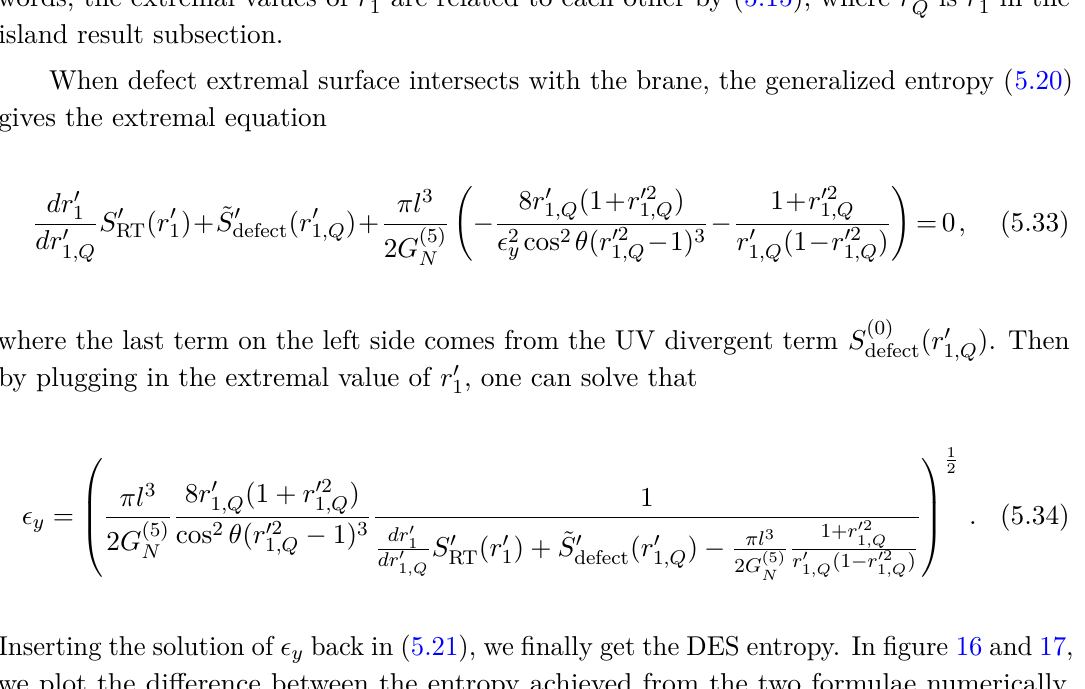
Figure 16 . Plot of the entropy difference divided by S DES . We pick 1 (cid:15) = 0 . 05